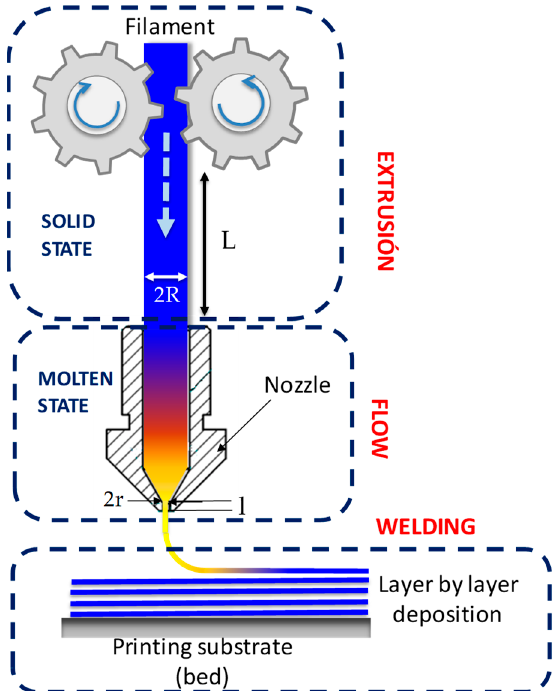
Figure 2. Geometric considerations for the occurrence of buckling.